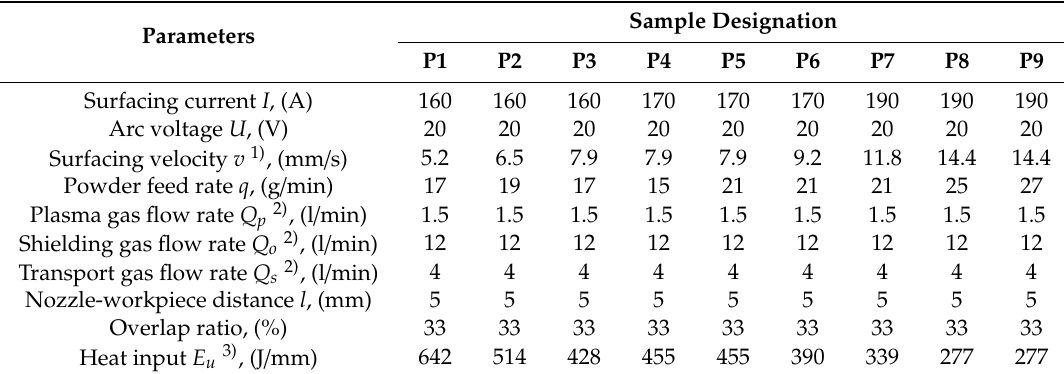
Table 6. Processing parameters of robotic plasma powder transferred arc surfacing of Inconel 625 superalloy layer on the outer surface of the 16Mo3 steel